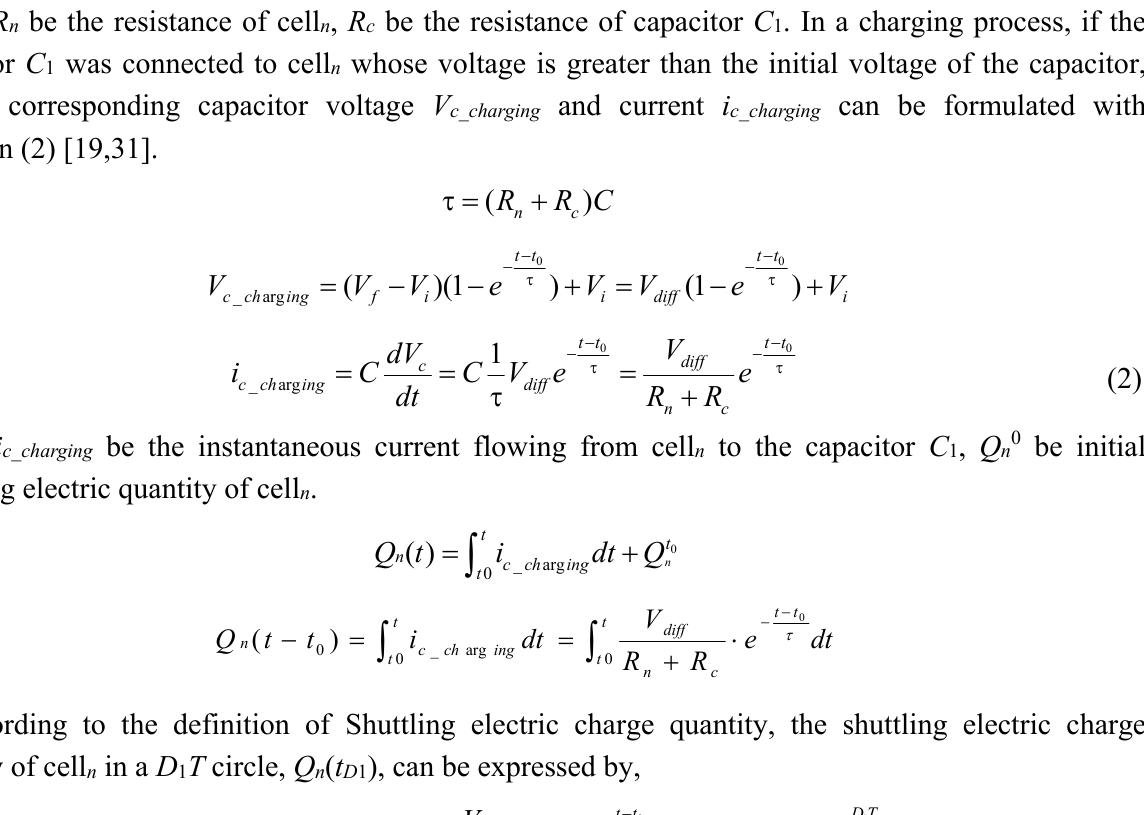
Figure 3. The voltage changes of the capacitor C 1